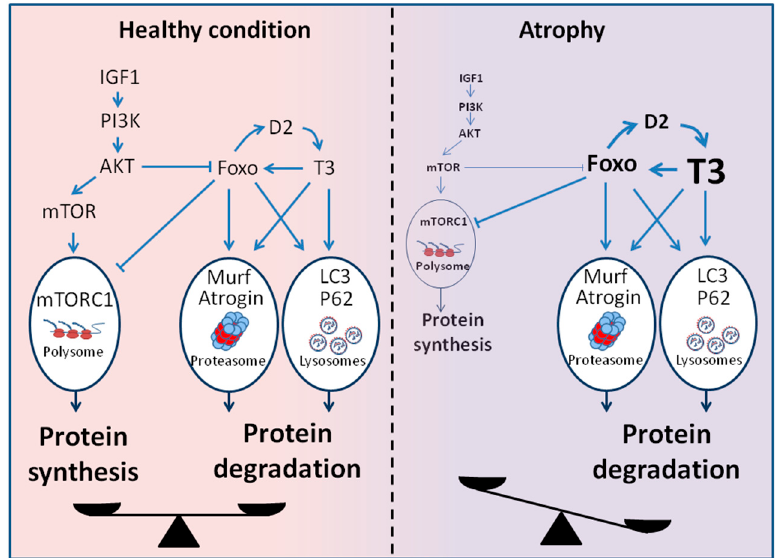
Figure 2. Signaling pathway involved in the regulation of the muscle mass. In healthy conditions, the balance between catabolic and anabolic signaling pathways allows the maintenance of muscle mass. In atrophic conditions, the rise in intracellular TH levels shifts this balance towards increased protein catabolism through the activation of canonical atrophic signaling pathways. (IGF1: insulin- like growth factor-1, PI3K: phosphatidylInositol 3-Kinase, AKT: protein kinase B, mTOR: